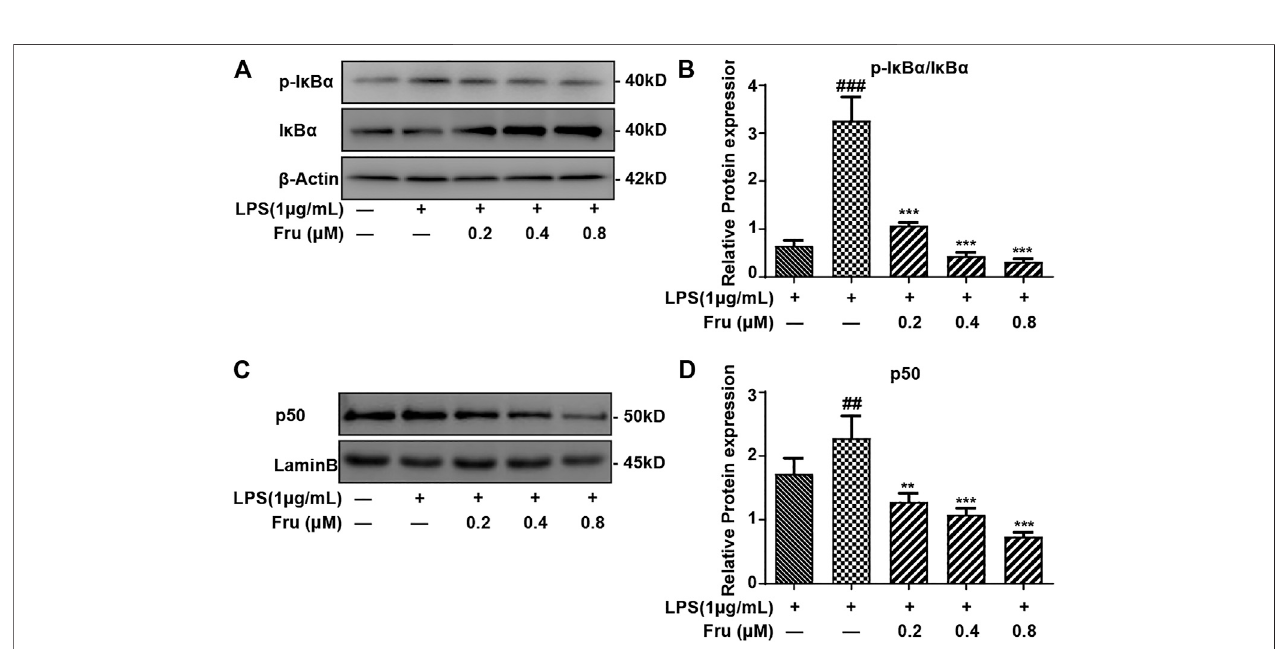
FIGURE 3 | Effect of Fru on activation of the NF- κ B pathway in LPS-stimulated RAW264.7 cells. RAW264.7 cells were incubated with different concentrations of Fru (0.2, 0.4, and 0.8 μ M) for 2 h before treated with 1 μ g/ml LPS for different times (30 min for I κ B α , p- I κ B α ; and 1 h for p50). The protein level of p- I κ B α /I κ B α (Panel (A,B) ), and p50 (Panel (C,D) ) were analyzed by Western Blot. Lamin B and β -actin were used as the internal control. Quantitative data were represented as mean ± SD ( n (cid:2) 3, ## p < 0.01, ### p < 0.001 vs. Control; ** p < 0.01, *** p < 0.001 vs. LPS).